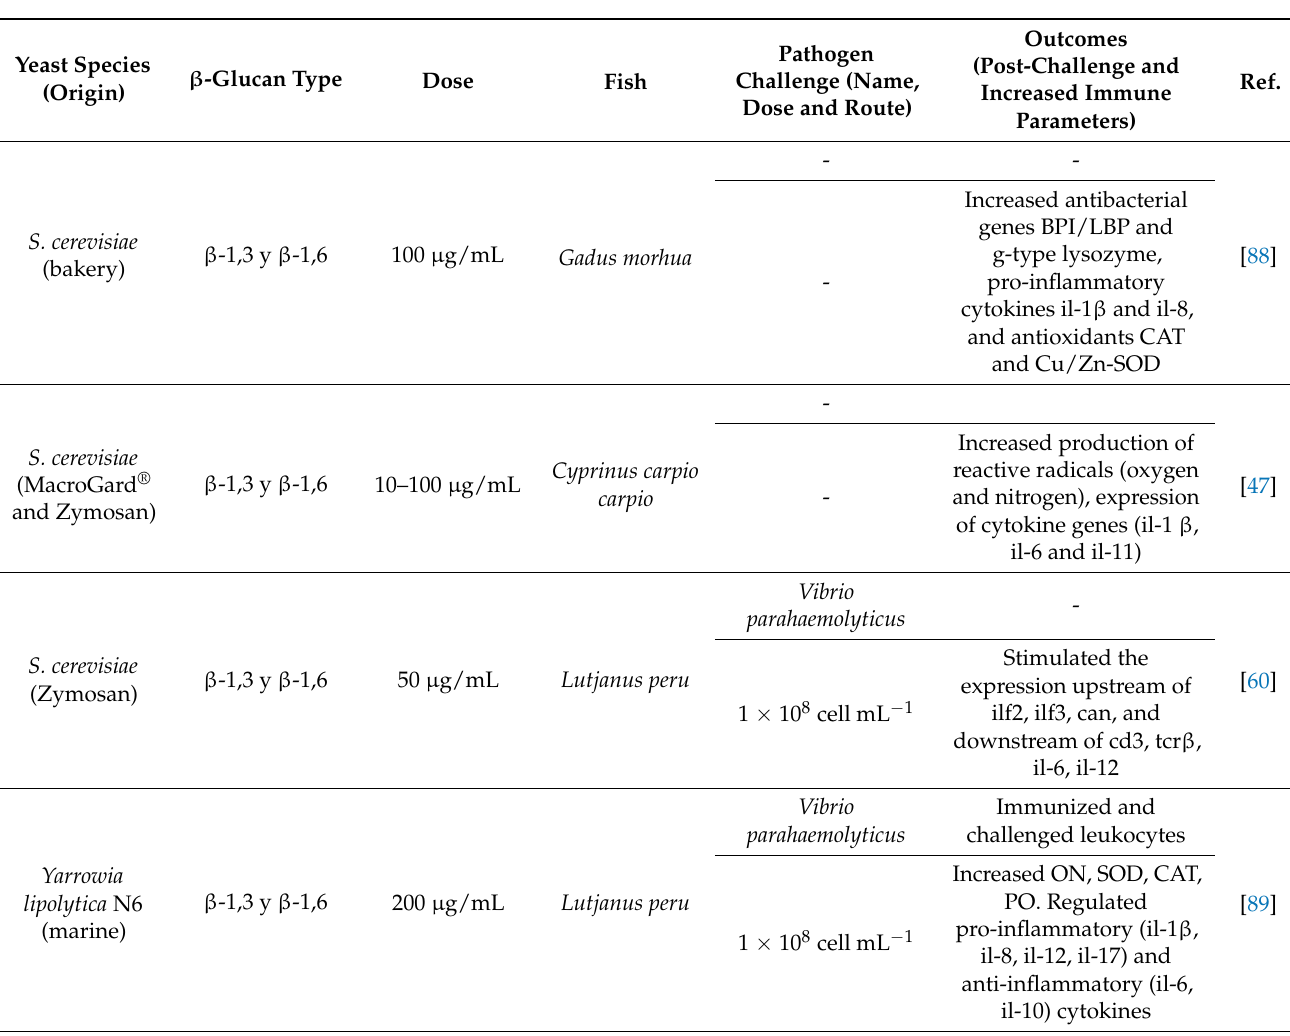
Table 4. In vitro effects of yeast β -glucans on the immune systems of freshwater and marine